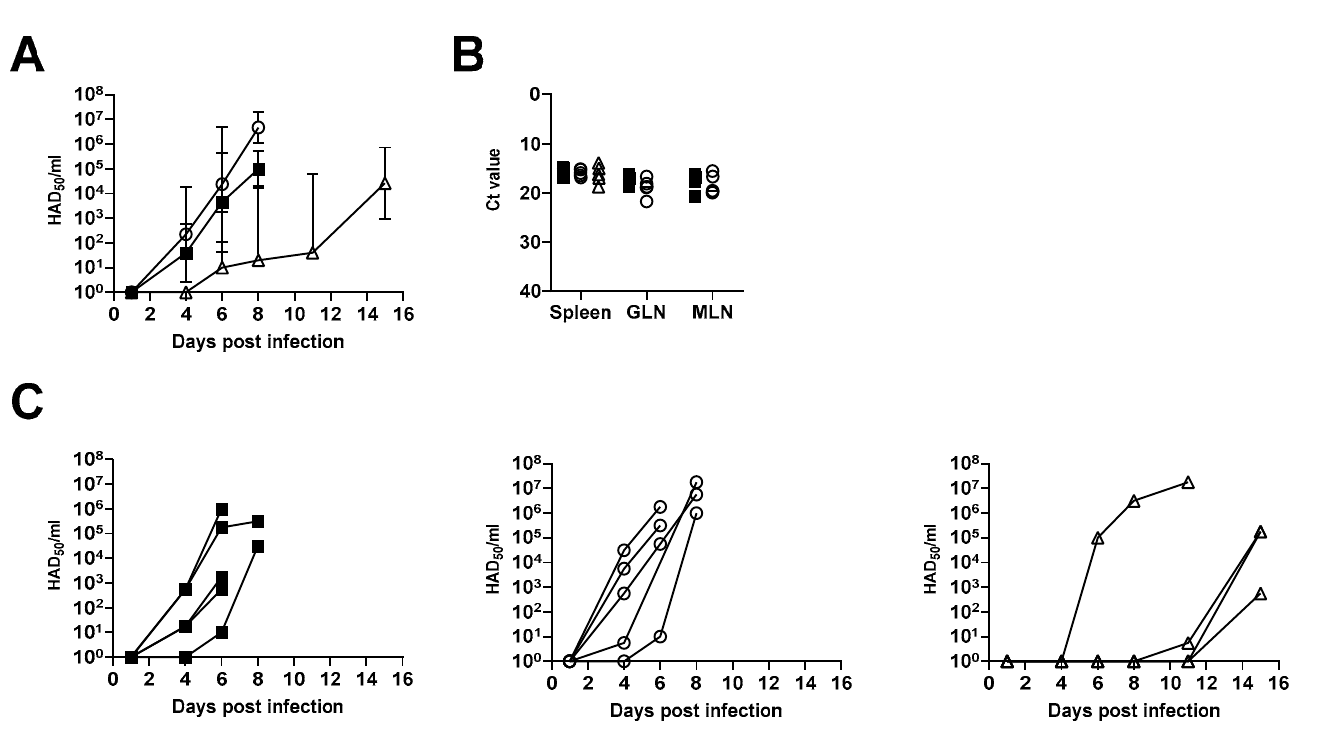
Figure 3. Viral titers in serum and tissues. ( A ) Mean virus titers (geometrical) ± SD (geometrical) in pig serum after inoculation with 10 2 TCID 50 of the WSL-grown virus ( ▪ ), 10 2 HAD 50 blood macrophage-grown virus ( ○ ), or 1 HAD 50 blood macrophage-grown virus ( ∆ ). HAD 50 titers in serum, the geometrical mean with the geometrical standard deviation, is displayed; ( B ) Ct values obtained by qPCR using DNA extracted from tissues obtained at postmortem from the spleen, gastro-hepatic lymph node (GLN), or mesenteric lymph node (MLN); ( C ) individual HAD 50 titers in serum.